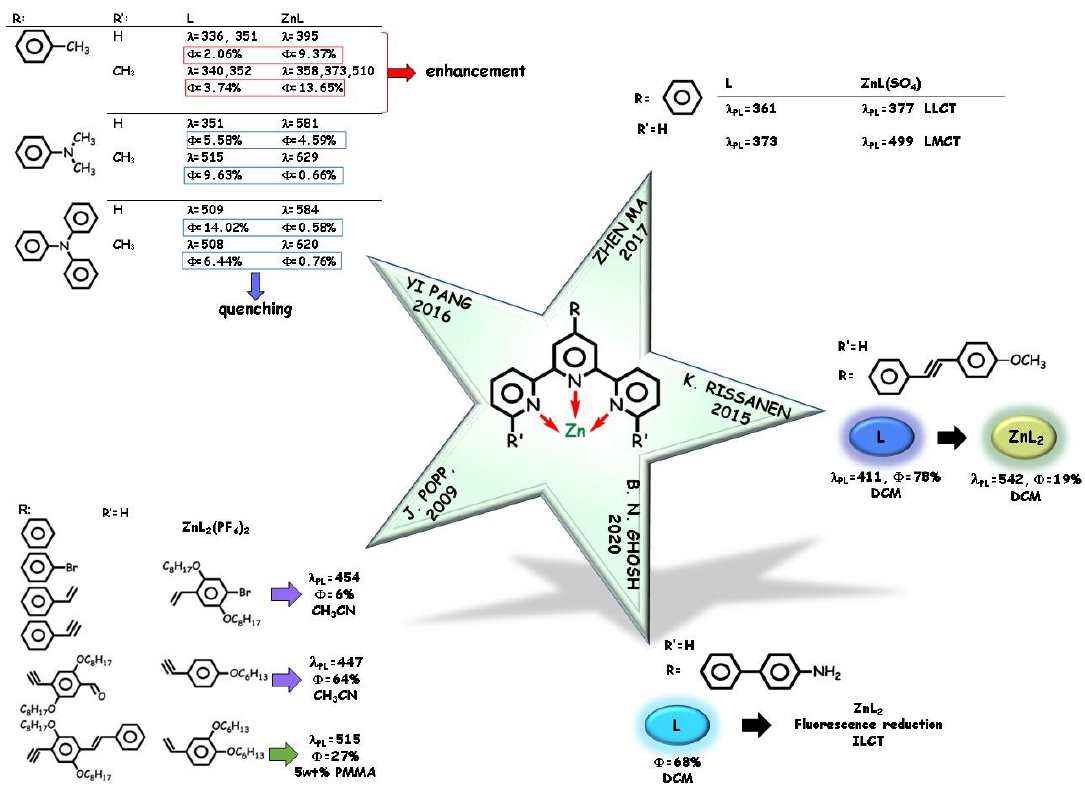
Figure 2. Tpy-type tridentate pincers causing zinc-binding fluorescence reduction/quenching.